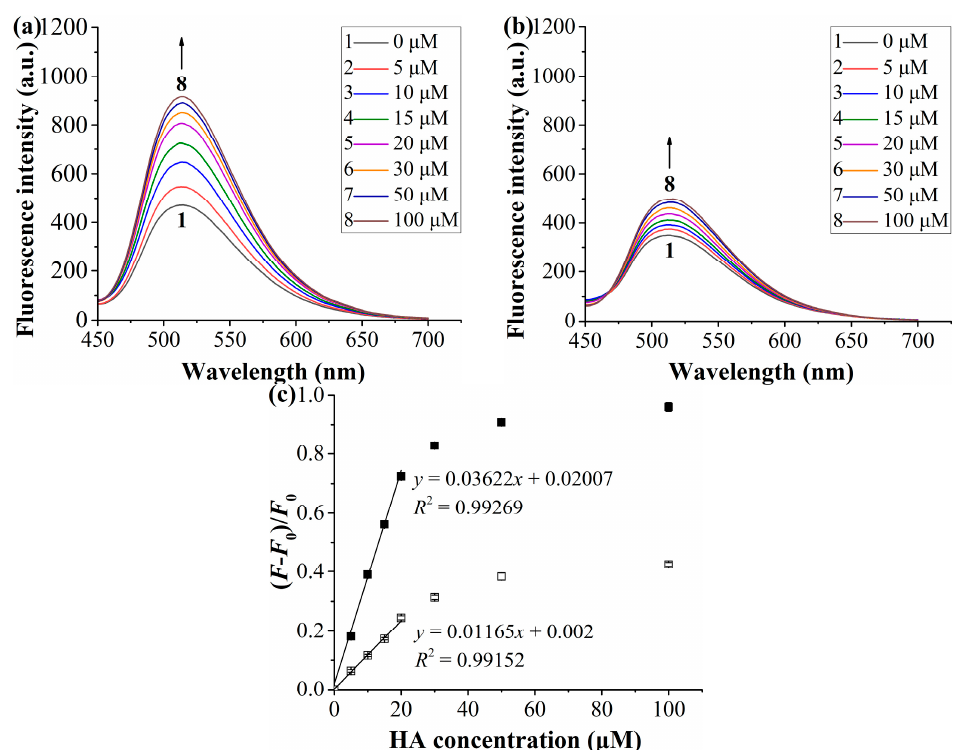
Figure 4. ( a , b ) Fluorescence spectra of the hydrophilic fluorescent hollow HA-MIP ( a )/CP ( b ) upon their exposure to different concentrations of HA in the artificial urine at 25 °C for 2 h (hollow MIP/CP concentration: 0.25 mg/mL; their concentration was calculated by using the weights of their solid counterparts before etching). ( c ) Dependence of the fluorescence enhancement [( F − F 0 )/ F 0 , where F and F 0 are the fluorescence intensity of NBD fluorophores at 514 nm in the presence and absence of HA, respectively] of the hydrophilic fluorescent hollow HA-MIP (filled symbol)/CP (open symbol) on the HA concentration (derived from Figure 4( a , b )).